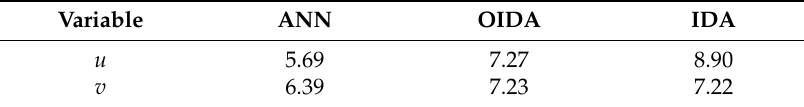
Table 10. RMSE between HFR data and model results (A3,